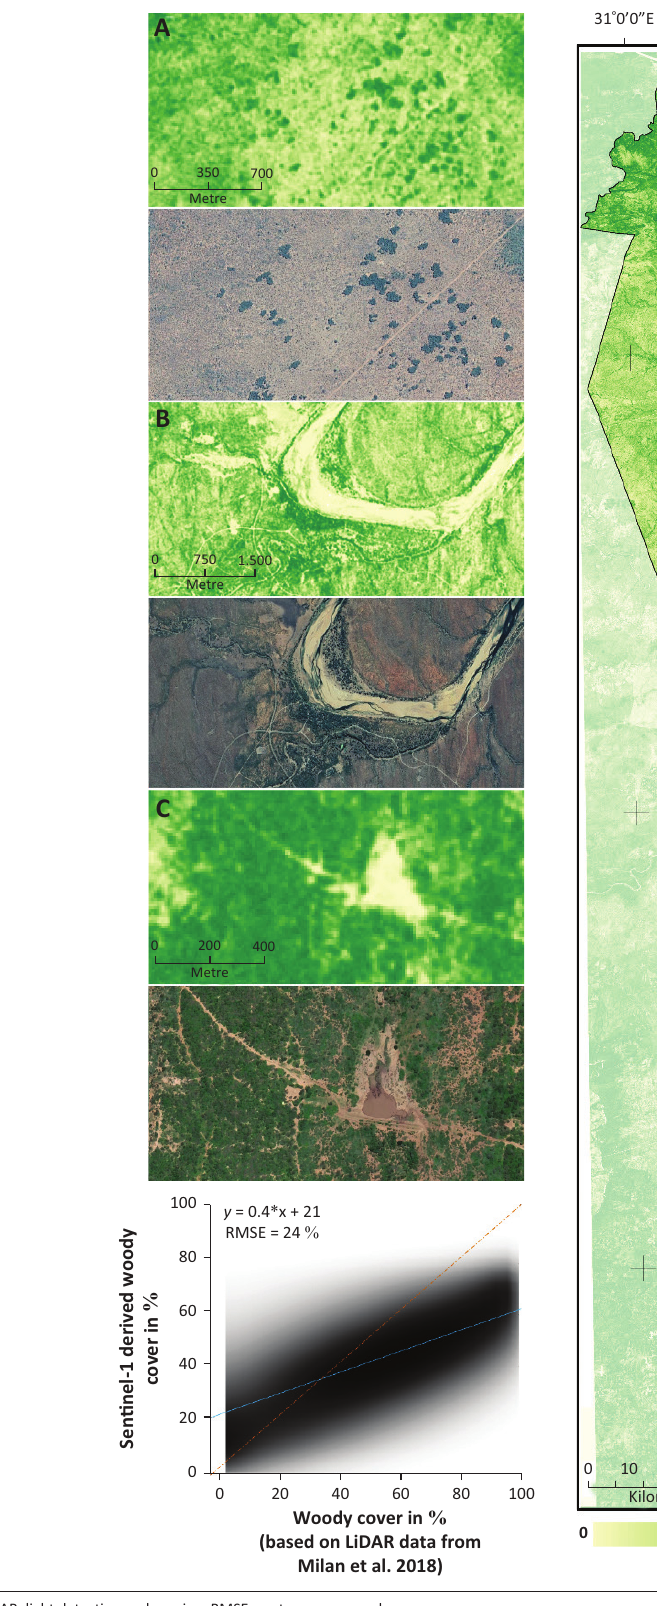
LiDAR, light detection and ranging; RMSE, root mean squared error. FIGURE 2: Wall-to-wall woody cover map of the Kruger National Park with a spatial resolution of 10 m (right). The footprints of the light detection and ranging data used for training (red, Smit et al. 2016) and independent validation (orange, Milan et al. 2018) are shown in the woody cover map. Comparison of the woody cover information to high-resolution imagery from Google Earth for three selected regions (A–C) as well as a scatterplot visualising the independent validation of the woody cover map with a woody cover estimate based on light detection and ranging data from Milan et al. (2018) (lower